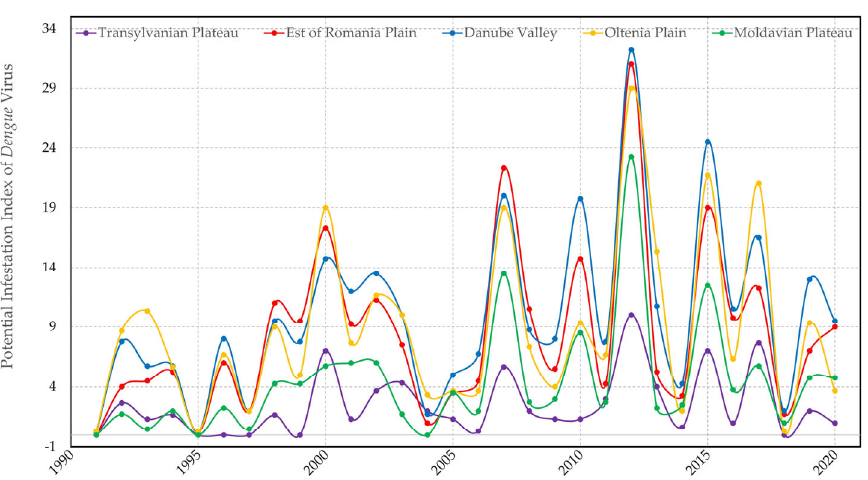
Figure 6. Periods of dengue virus replication inside the